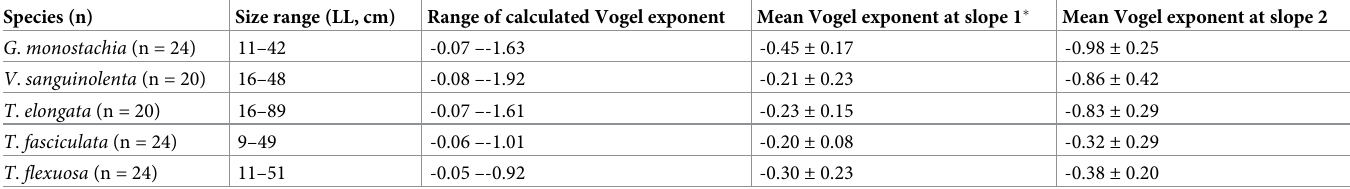
Table 2. Range of Vogel exponents and size range (LL, longest leaf length) of each species. Species (n) Size range (LL,